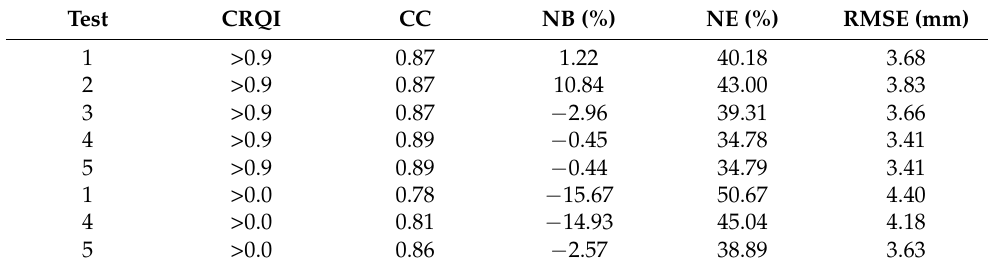
Table 4. Statistical scores of tests